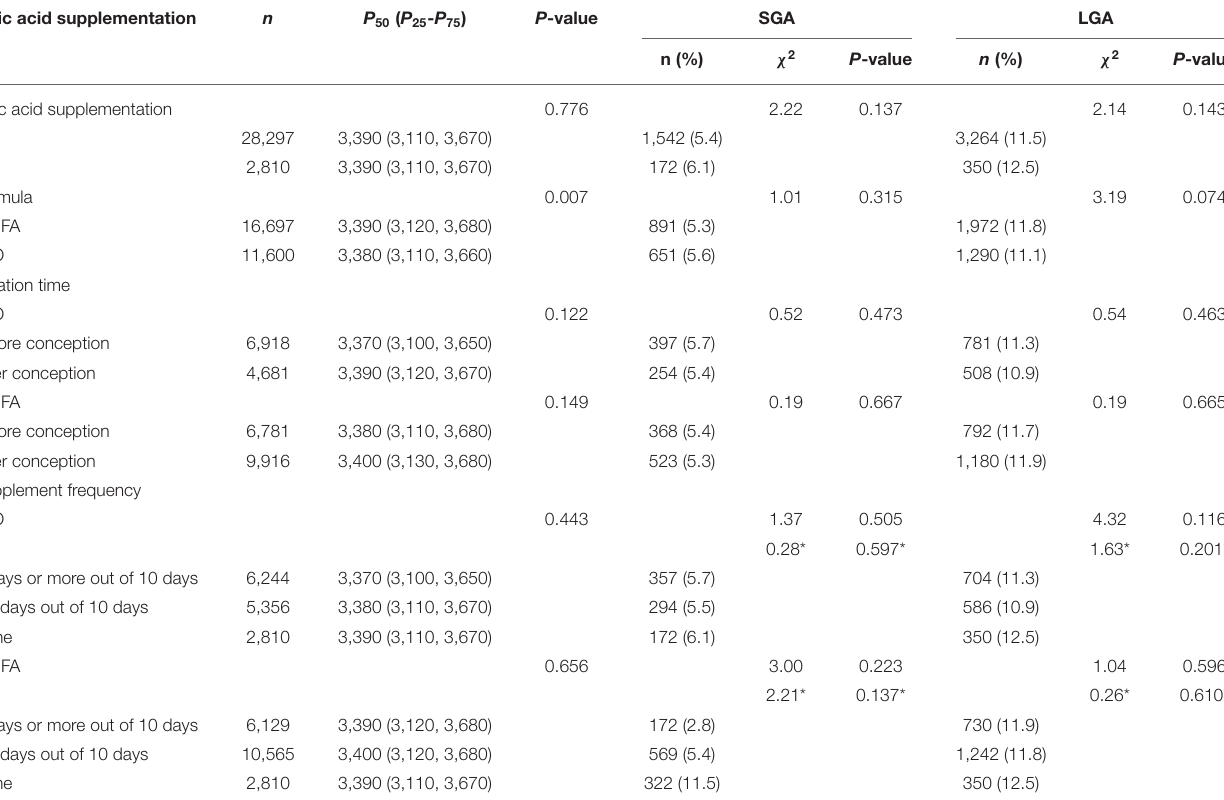
TABLE 4 | Periconceptional folic acid supplementation and the birth weight of newborns as well as risk of SGA or LGA, univariate analysis. Folic acid